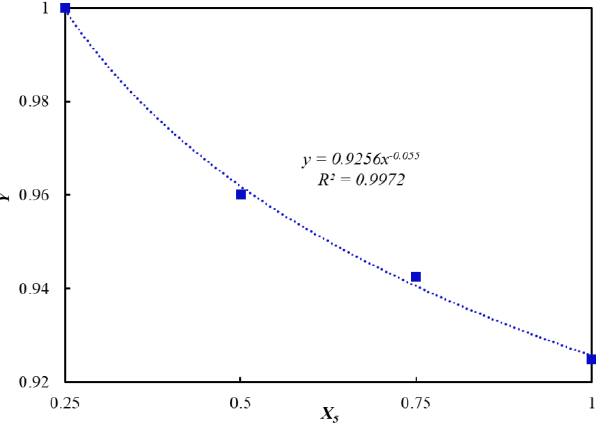
Figure 13. The influence of formation elastic modulus on downhole perforation peak pressure.